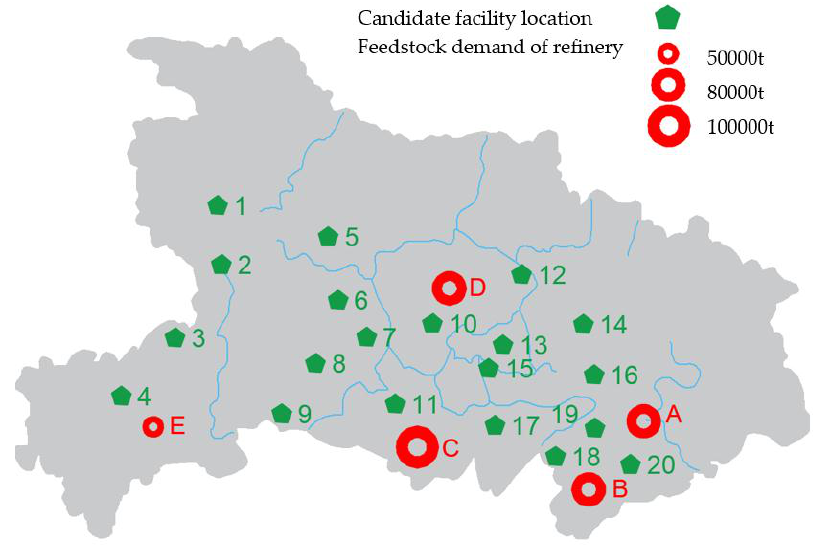
Figure 4. Geographical distributions of collection facilities and refineries.